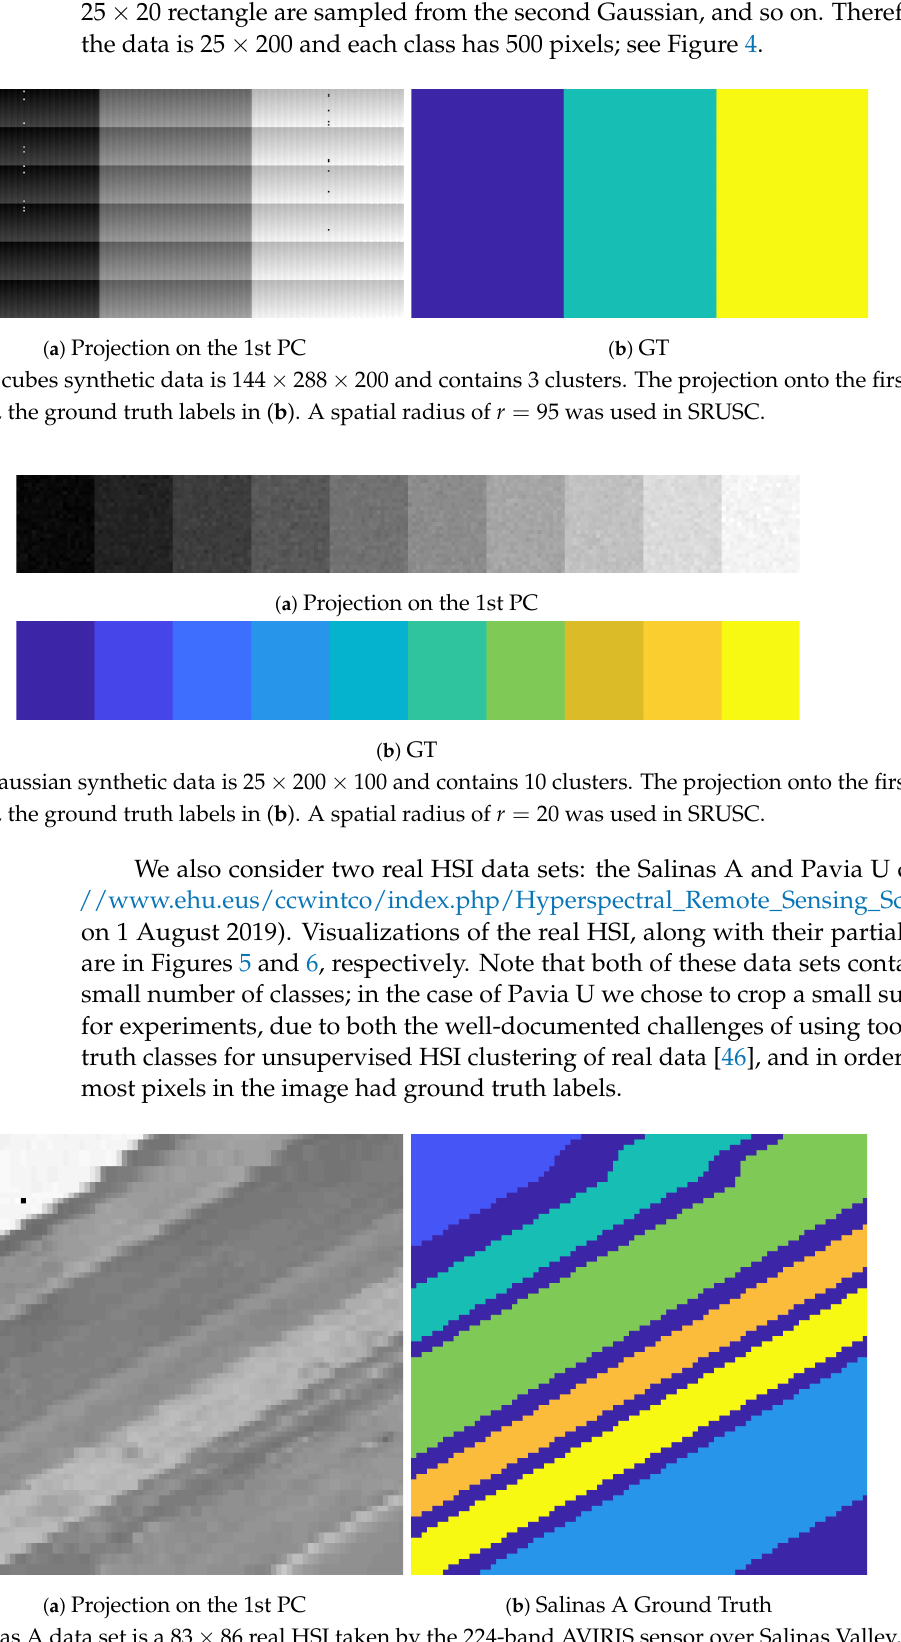
Figure 5. The Salinas A data set is a 83 × 86 real HSI taken by the 224-band AVIRIS sensor over Salinas Valley, California. There are 6 clusters in the ground truth. The projection onto the first principal component is in ( a ), the ground truth labels in ( b ). A spatial radius of r = 65 was used in